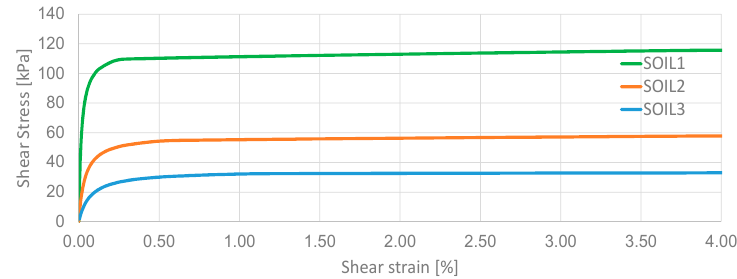
Figure 2. The finite element mesh (indications: dimensions and lateral boundaries).